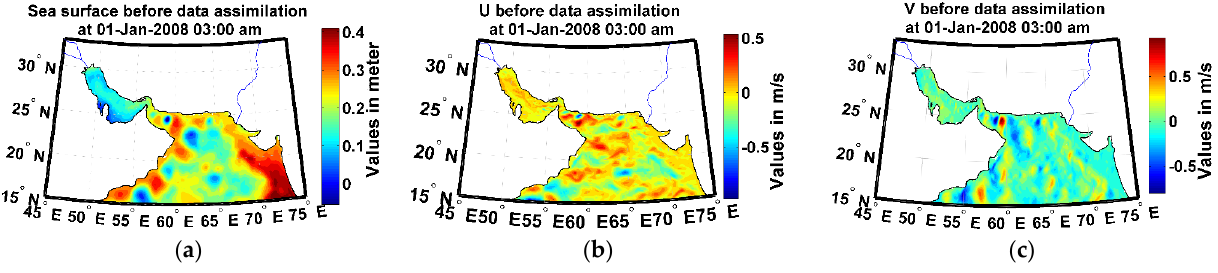
Figure 1. ( a ) Sea level height before data assimilation (calibration); ( b ) east–west component (u) of the SSC before data assimilation; ( c ) north–south component (v) of the SSC before data assimilation.